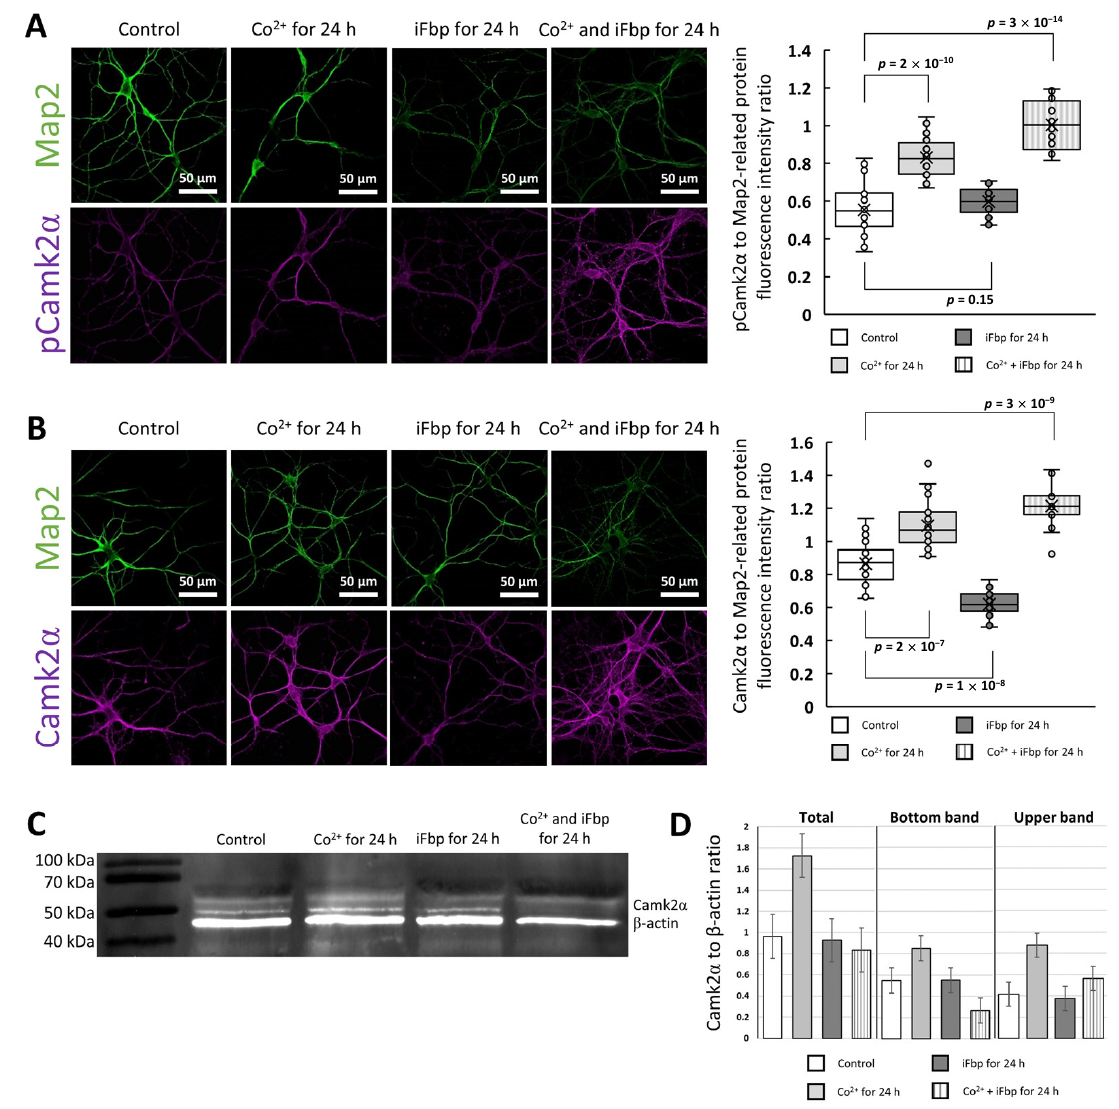
Figure 5. The effect of Co 2+ on the amount of total and phosphorylated Camk2 α in neurons. The fluorescence related to total Camk2 α ( A ) and pThr286 Camk2 α ( B ) is significantly elevated in neurons incubated with Co 2+ and Co 2+ /iFbp, whereas in the cells treated with iFbp alone, the signal related to total Camk2 α decreases and pThr286 Camk2 α -related fluorescence is unaltered. ( C ) Western blot and its densitometric analysis ( D ) reveals that the total amount of the kinase is increased only in Co 2+ -treated neurons, whereas the level of pThr286 Camk2 α is higher in Co 2+ - and Co 2+ /iFbp-incubated